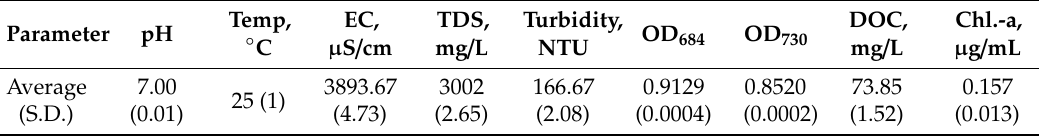
Figure 1. M. aeruginosa cultures. ( a ) Initial stage (after inoculation) and ( b ) after 14 days. Table 2. Characteristics of M. aeruginosa suspensions prepared for electro-coagulation–flotation treatment ( n = 3).